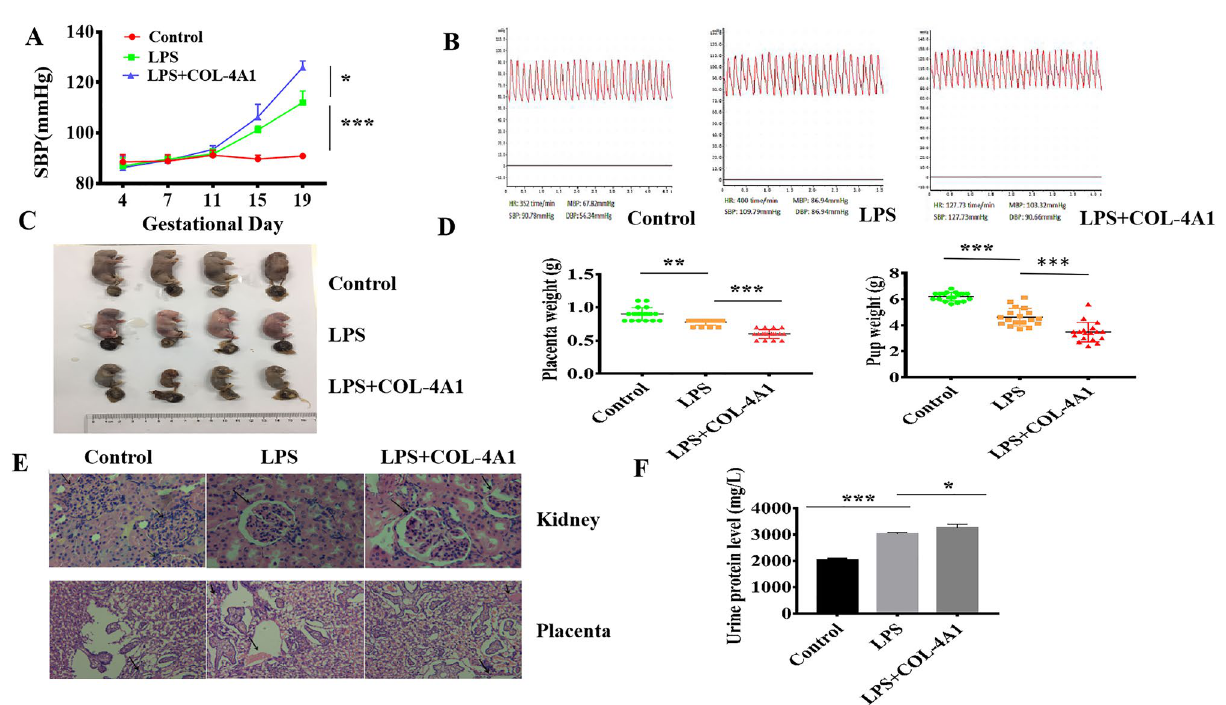
Figure 1. COL-4A1 aggravated PE-like symptoms in a rat model treated with or without LPS. ( A ) The SBP of the control (saline) (n = 6), LPS (PE) (n = 6) and LPS + COL-4A1 (PE + COL-4A1) (n = 6) groups was